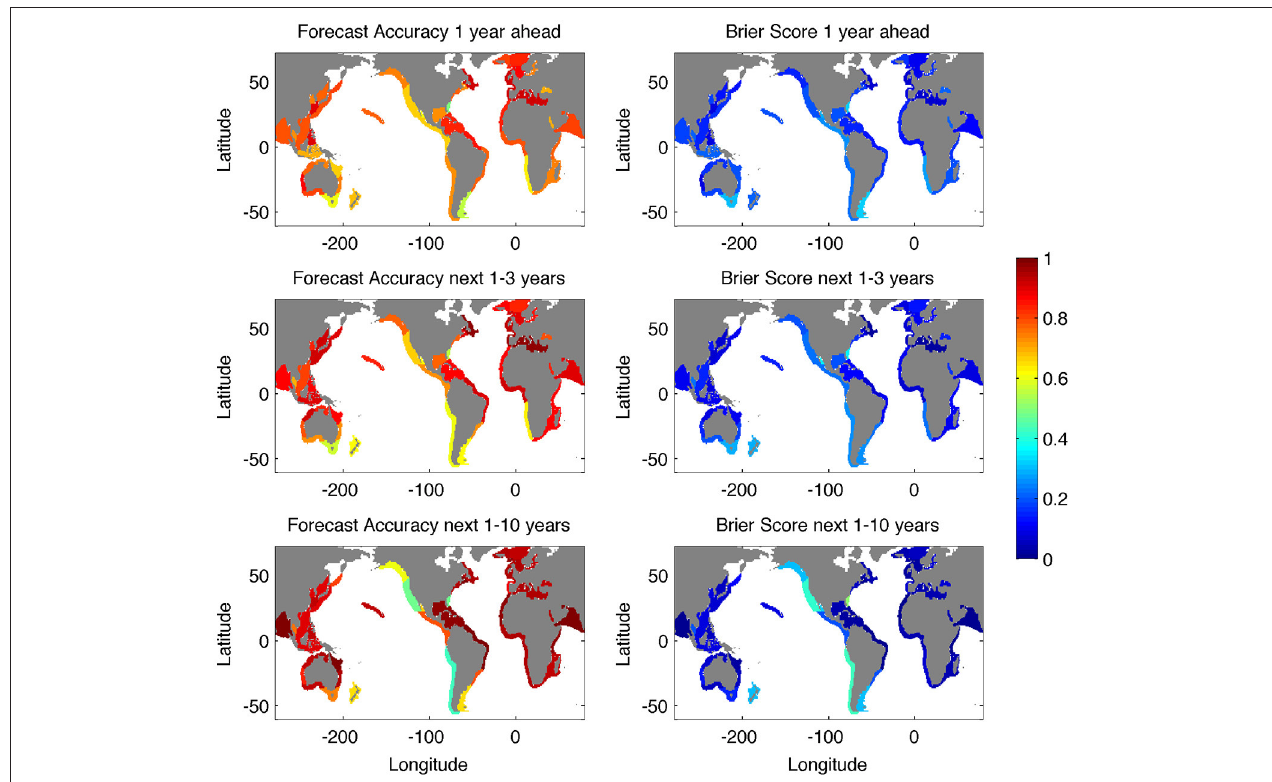
FIGURE 3 | Forecast accuracy (left) and Brier Score (BrS, right ) for lower SST tercile predictions for a 1 year ahead forecast and over the next 3 and 10 years. Forecast accuracy ranges between 0 and 1 (perfect skill). The BrS ranges from 0 (perfect score) to 1 (no